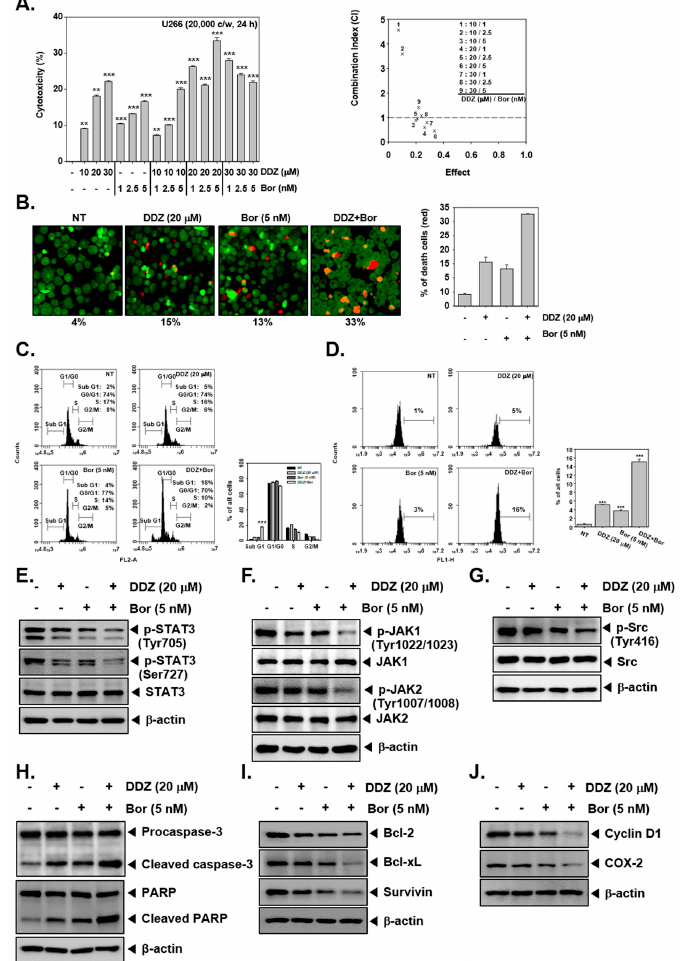
Figure 5. DDZ and bortezomib (Bor) could augment apoptotic effects. ( A ) To determine the effect of DDZ and bortezomib (Bor) on cytotoxicity, an MTT assay was done. U266 cells (2 × 10 6 cells/well) were treated with DDZ and Bor at the indicated concentrations for 24 h. The average of the combination index (CI) values was calculated for mine separate combinations. A CI lower than 1 was regarded as synergistic, a CI of 1 was regarded as additive, and a CI higher than 1 was regarded as antagonistic. The average of CI values for various combinations suggests that the best combination ratio was 20 μ M of DDZ and 5 nM of Bor. ( B ) Live and Dead assays were performed to determine the combinatory effects of DDZ and Bor. U266 cells were treated as described above. Live cells were stained in green, and dead cells were stained in red. The graph (right) shows the rate of dead cells by quantification. ( C ) U266 cells were treated with 20 μ M of DDZ and 5 nM of Bor for 24 h, and then the cells were analyzed by flow cytometry. ( D ) The cells were treated as described above, then stained with TUNEL assay reagent, and analyzed with flow cytometry. ( E )–( G ) U266 cells (1 × 10 6 cells / well) were treated with 20 µ M of DDZ and 5 nM of Bor for 3 h. Whole cell lysates were prepared, and western blotting for various proteins was done. ( H )–( J ) U266 cells (1 × 10 6 cells / well) were treated as described above in panel ( C ), and western blot analysis was carried out. The results are presented as the mean ± SD. *** p < 0.001 compared the